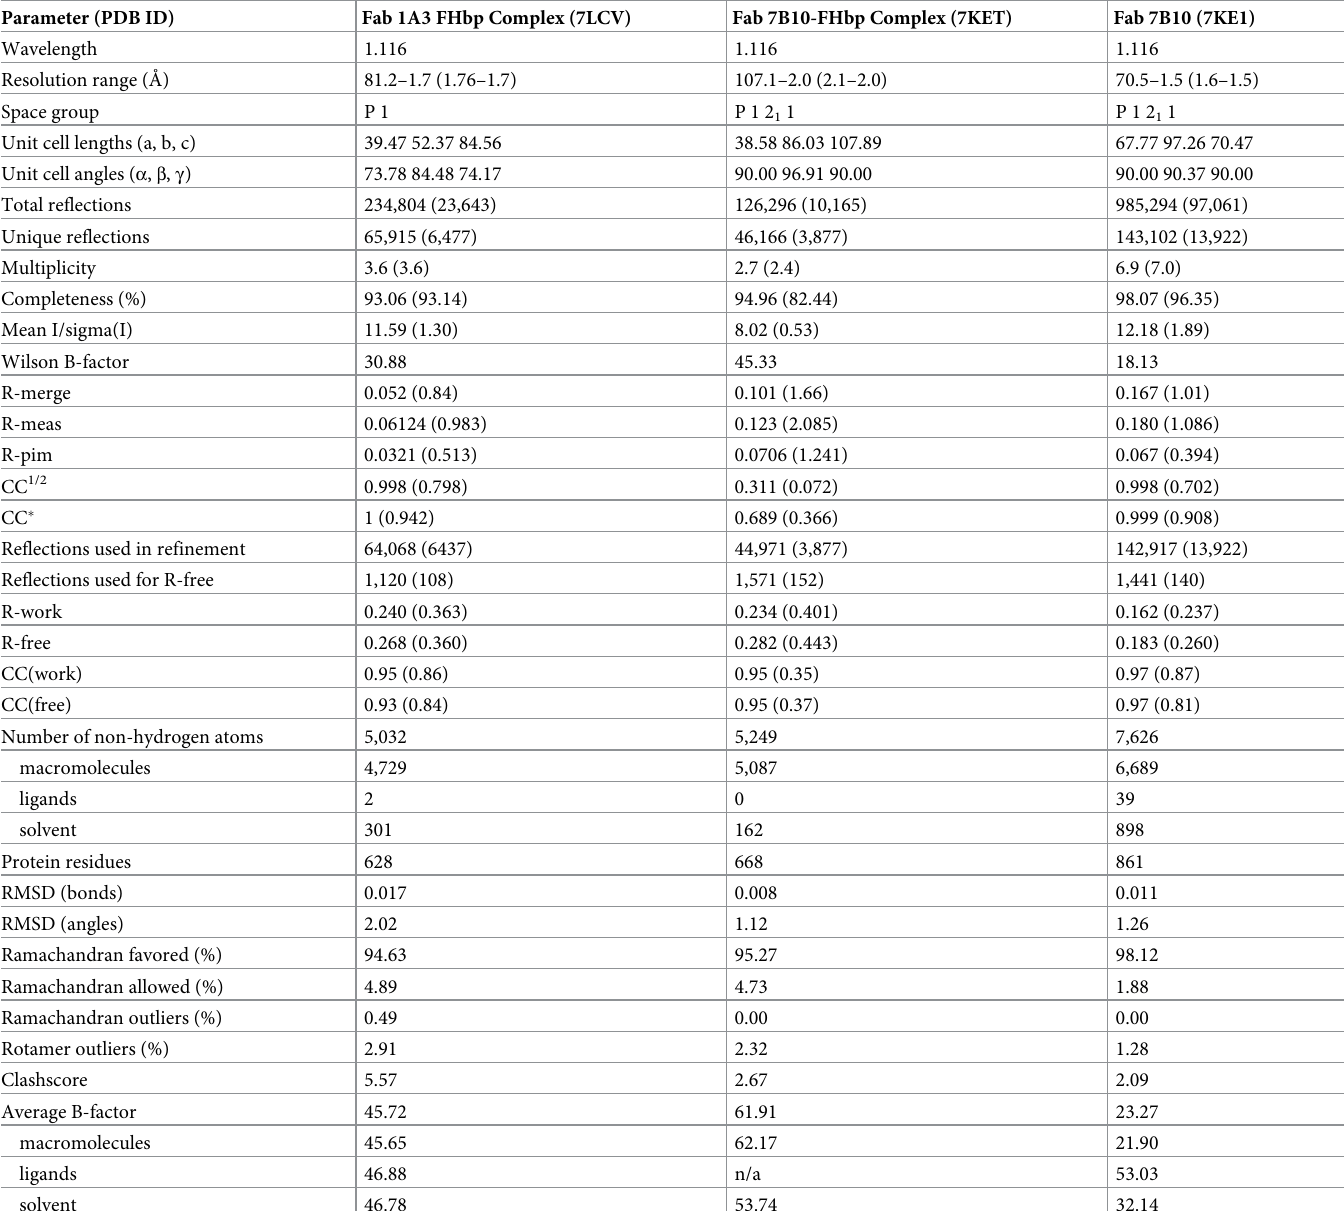
Table 1. X-ray data collection and refinement statistics a